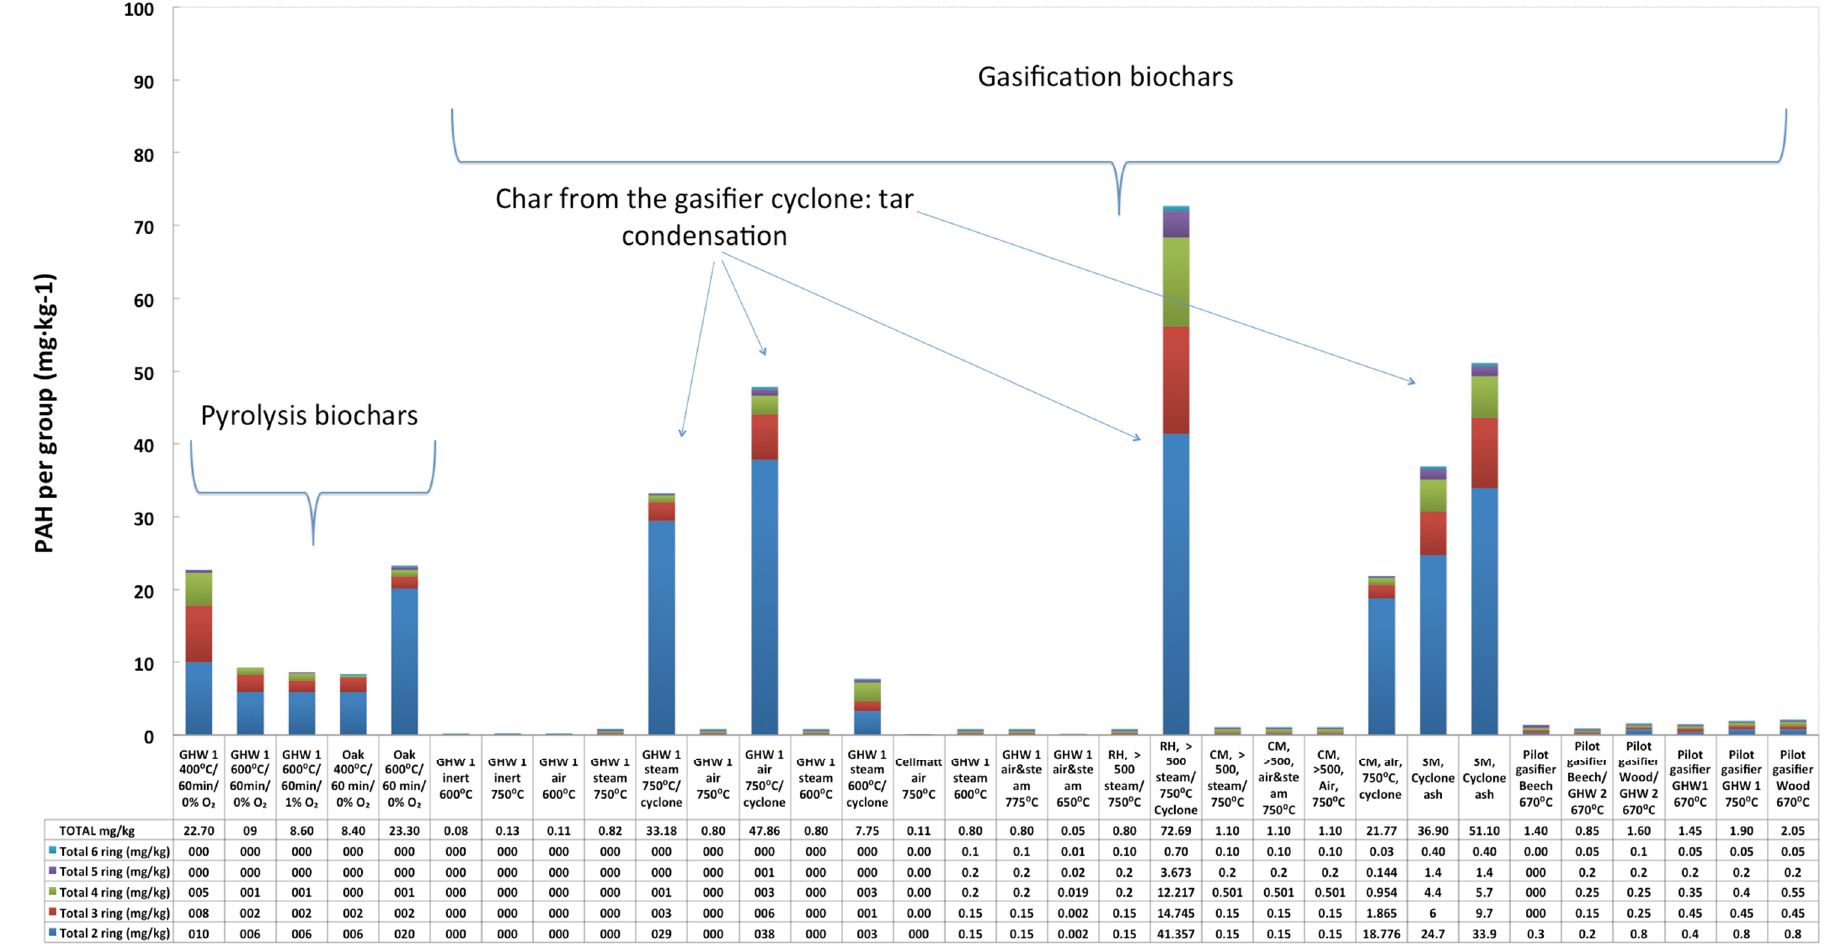
Figure 6. Polycyclic aromatic hydrocarbons (PAH) per group (1-5 ring tars) for each biochar sample. The first five columns refer to the pyrolysis biochar samples. The next biochars come from the gasifier, some of the columns are marked ‘cyclone’, representing material analyzed form the cyclone part at the reactor exit. The last six columns represent the biochar samples from the larger-scale gasifier (from the bed). Please note that in every column the results are presented, even if the amounts are hardly